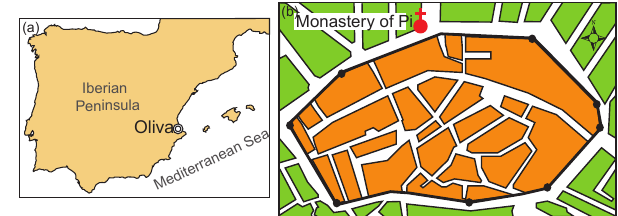
Figure 2. (a) Location of Oliva (b) map of Oliva from the early 17th century (modified from Brines et al.,